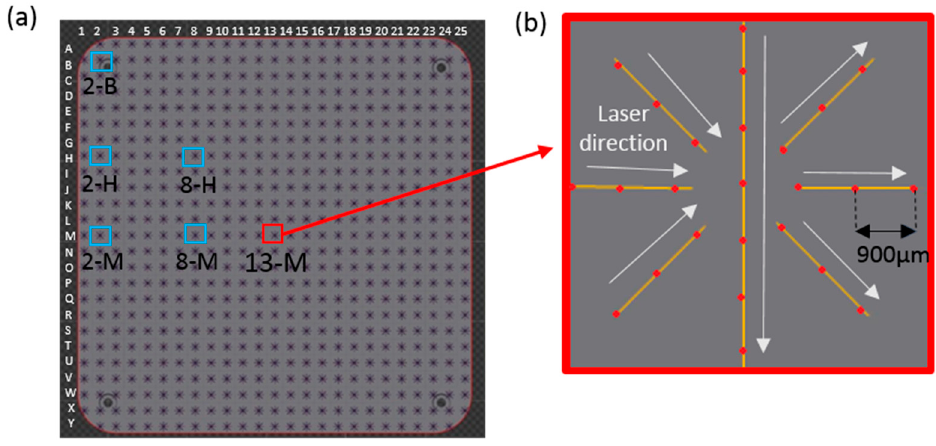
Figure 2. Test design to analyze the influence of laser inclination angle on the platform: ( a ) Distribution of the marks in the platform.; ( b ) Marks made on the platform in a star shape defining the laser strategy used.